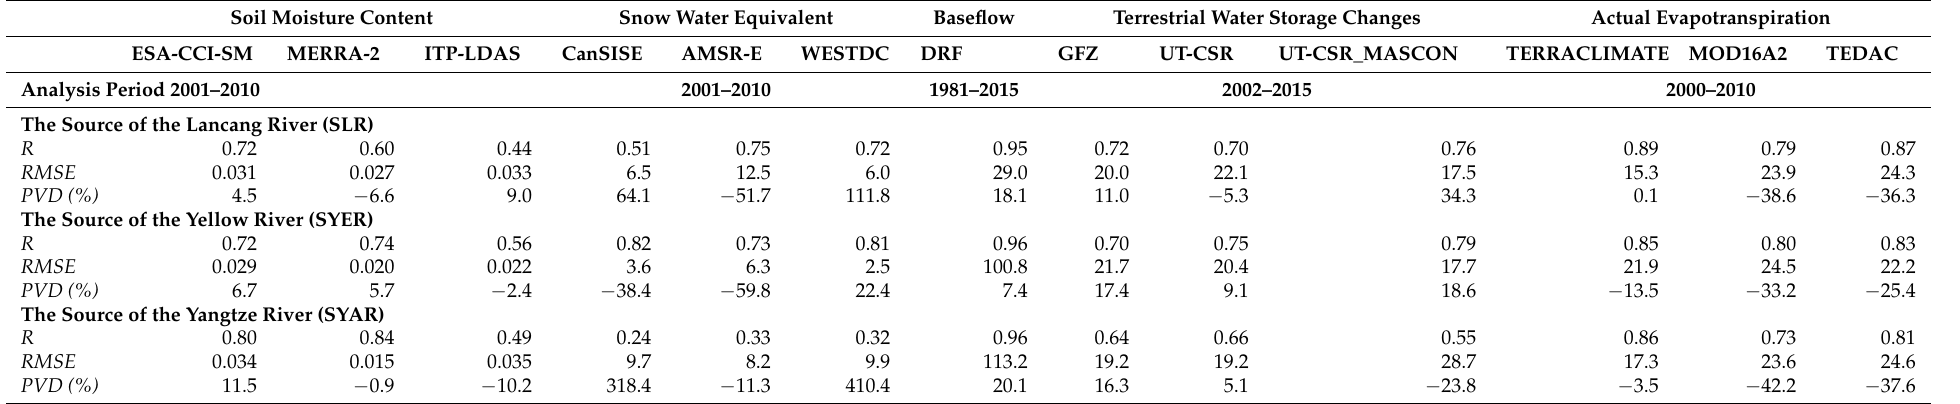
Table 6. Evaluation of HEC-HMS using different hydrologic components in the